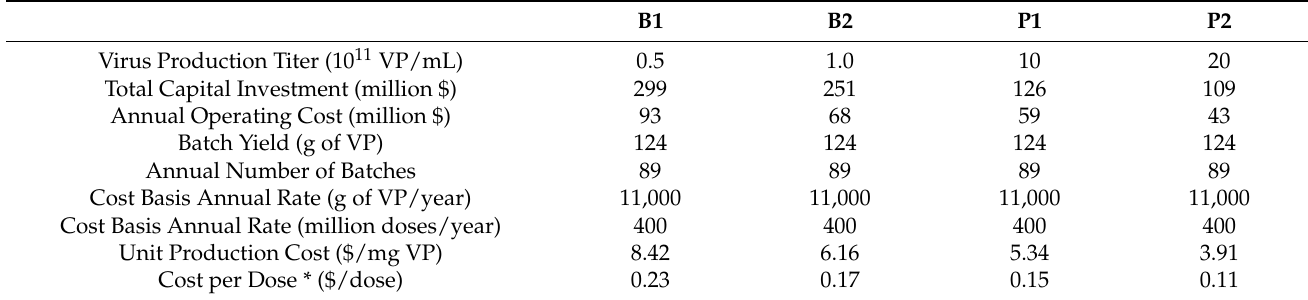
Table 9. Executive summary. B1 and B2 refer to scenarios based on batch cell culture, while P1 and P2 refer to scenarios based on perfusion cell